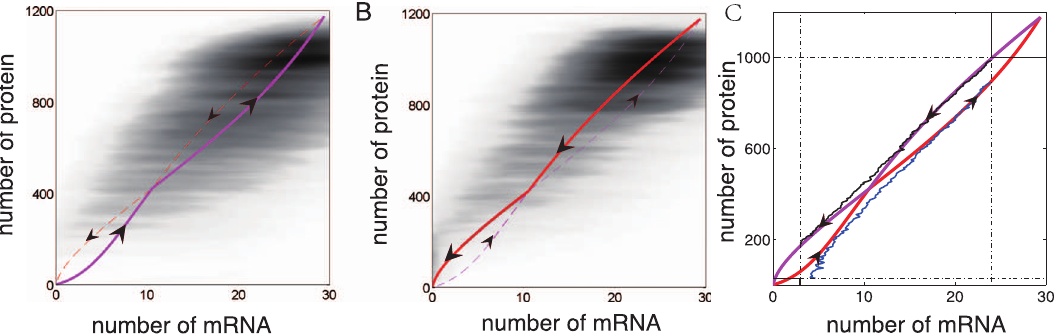
Figure 2. Switching paths (A) from off to on state (purple solid curve) and (B) from on to off state (red solid curve) and MC simulations for both switching trajectories. We take the two stable fixed points in the deterministic dynamics as the starting and ending points. Darkness of the shading points represents the number of visits for reactive trajectories with smoothing. (C) Averaged switching trajectories from MC simulation. For each number of protein, we average in the mRNA dimension using probability as weight. Here the statistical results around each stable state is not shown because of the restrictions by our MC simulation algorithm (see Text SI:VI-A). The results are obtained from 1000 independent long time MC simulations. The parameters here are k 0 ~ 1 , c 0 ~ 50 , a 0 ~ 0 : 4 , a ~ 400 , b ~ 40 , c m ~ 10 , c n ~ 1 , k 1 ~ 0 : 0002 , and c 1 ~ 2 :